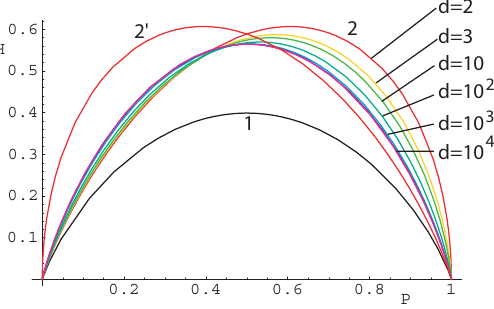
Figure 2. Comparison of noise entropies for straight line solutions (1) and circles with spiking on the outside (2) or inside (2 9 ) for Gaussian inputs. The entropy for circular solution depends on the dimensionality d of inputs as illustrated here in the case of spiking outside of a circle.